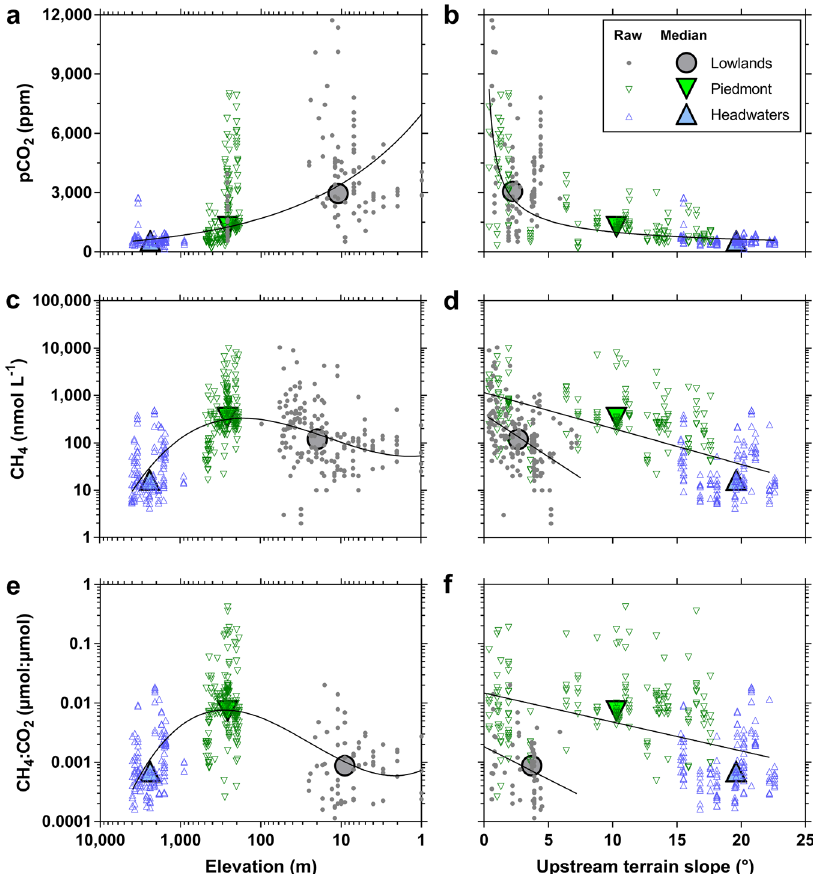
Fig. 4 Strong elevation gradients of pCO 2 and CH 4 in streams and rivers across the whole Amazon basin. Variations of the partial pressure of CO 2 (pCO 2 ), CH 4 dissolved concentration, and the ratio of CH 4 and CO 2 (CH 4 :CO 2 ) concentration as function of elevation ( a , c , e ) and catchment slope ( b , d , f ). Data in the lowland rivers and streams was compiled from literature for pCO 2 25,35 – 37,39 and CH 4 15,16,31,39 . For consistency, only studies based on direct measurements of pCO 2 were selected, excluding data derived from the computation of pCO 2 from pH and total alkalinity, as this computation can provide erroneous and unrealistically high pCO 2 values 113 . Data from Sco fi eld et al. 38 was excluded because the pCO 2 values reported by these authors in the Negro River (upstream of Manaus) were distinctly lower (710 ppm during low water period and 2608 ppm during higher water period) than other studies in the same system 25,27,29,36 (~2000 – 3000 ppm during low water period and ~5000-8000 ppm during higher water period). Small symbols show individual measurements, large symbols indicate the median; the blue triangles show the data in the mountainous headwater streams, green triangles show the data in piedmont streams, and the grey circles show the data in the lowland streams and rivers, and black lines indicate linear or polynomial fi ts to the data. Solid lines show fi ts to the data (Supplementary Table